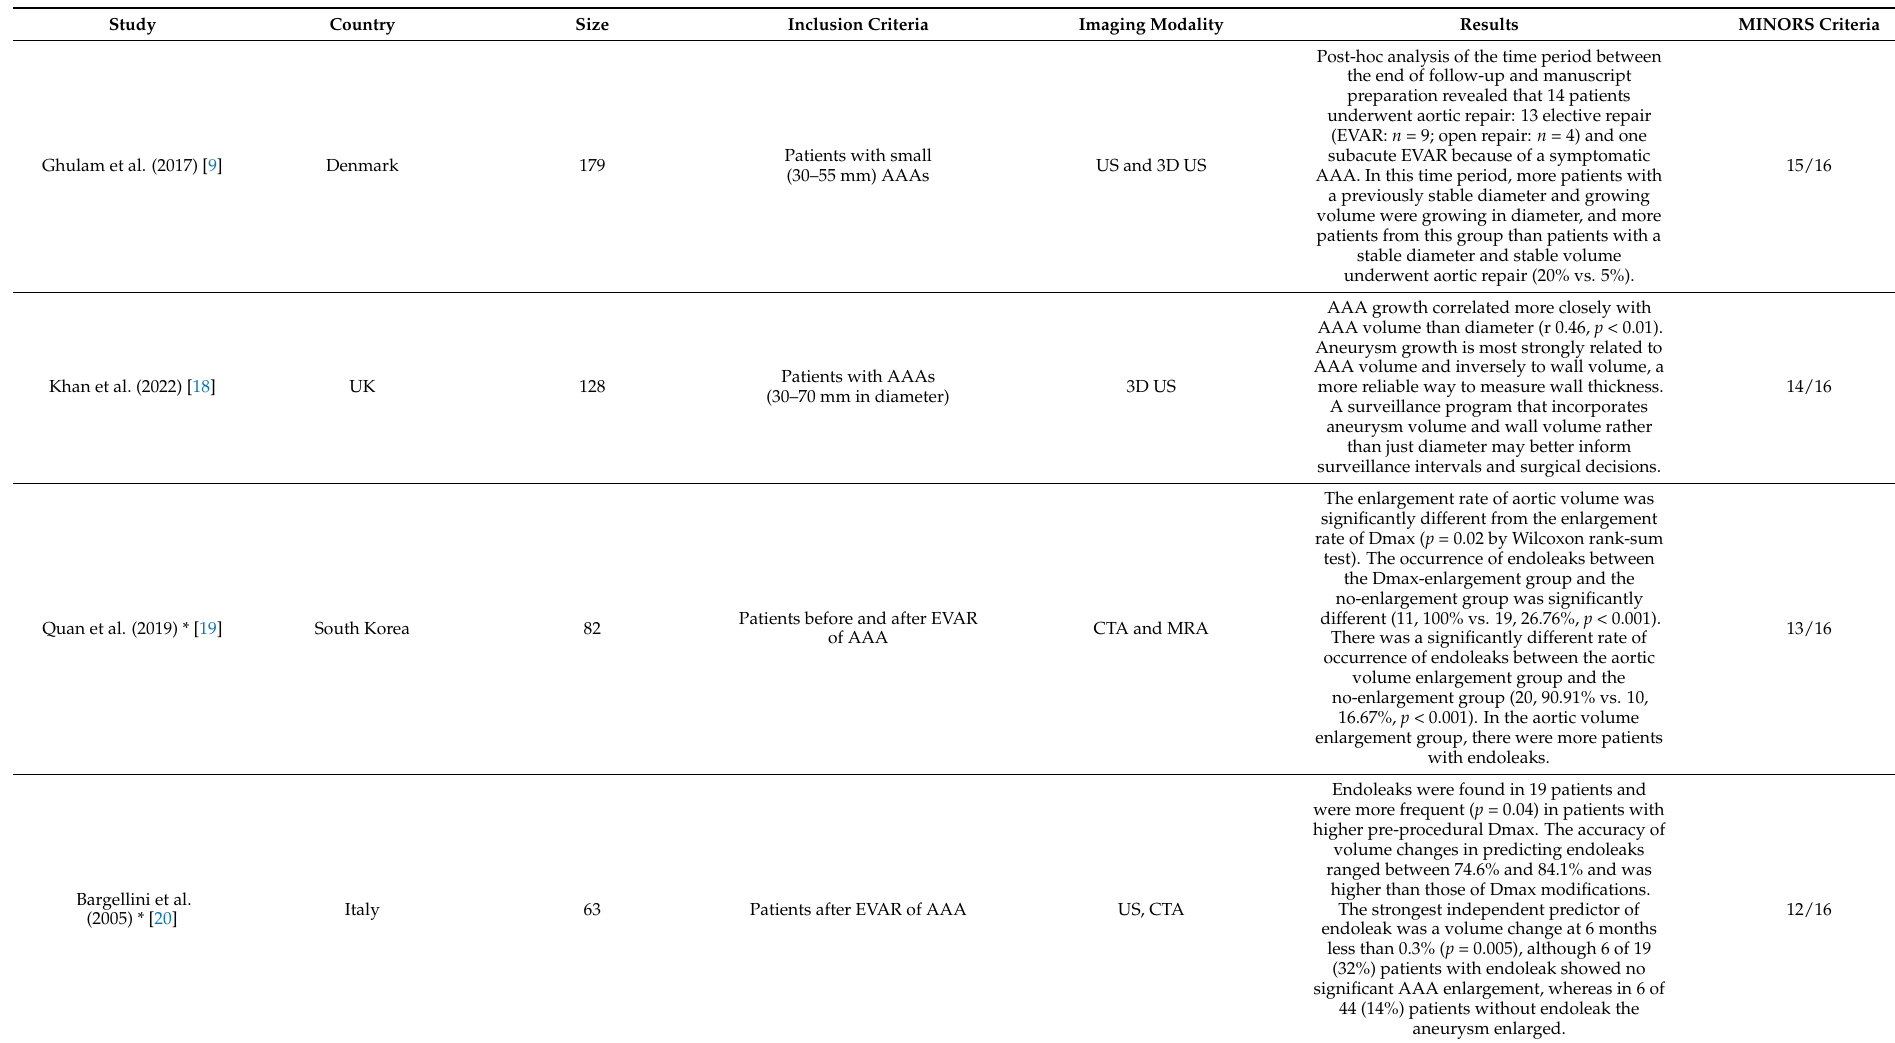
Table 4. Summary of studies favoring volume